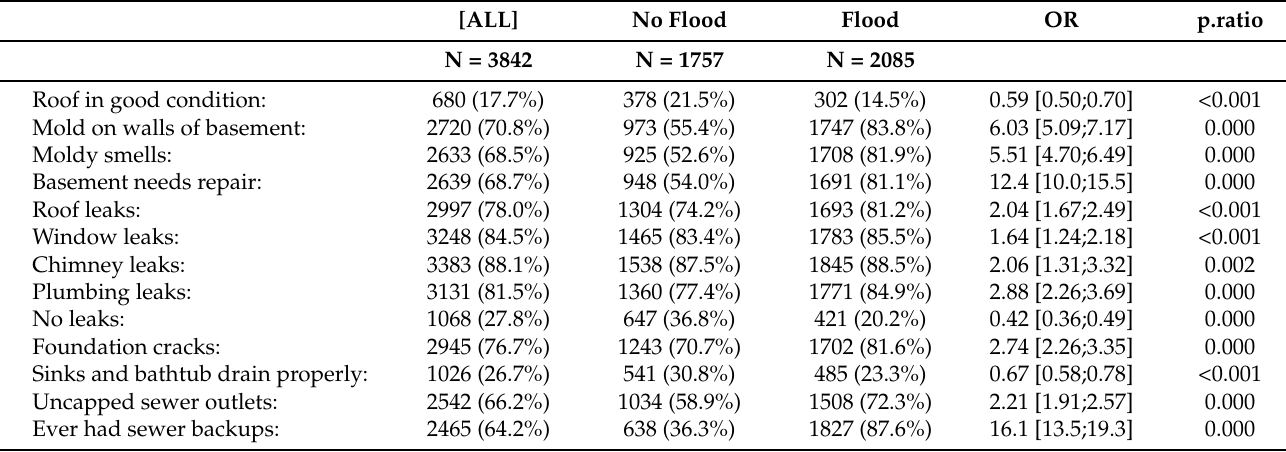
Table 2. Housing conditions and flooding. Housing condition measurements were self reported by residents and confirmed by survey workers where possible.